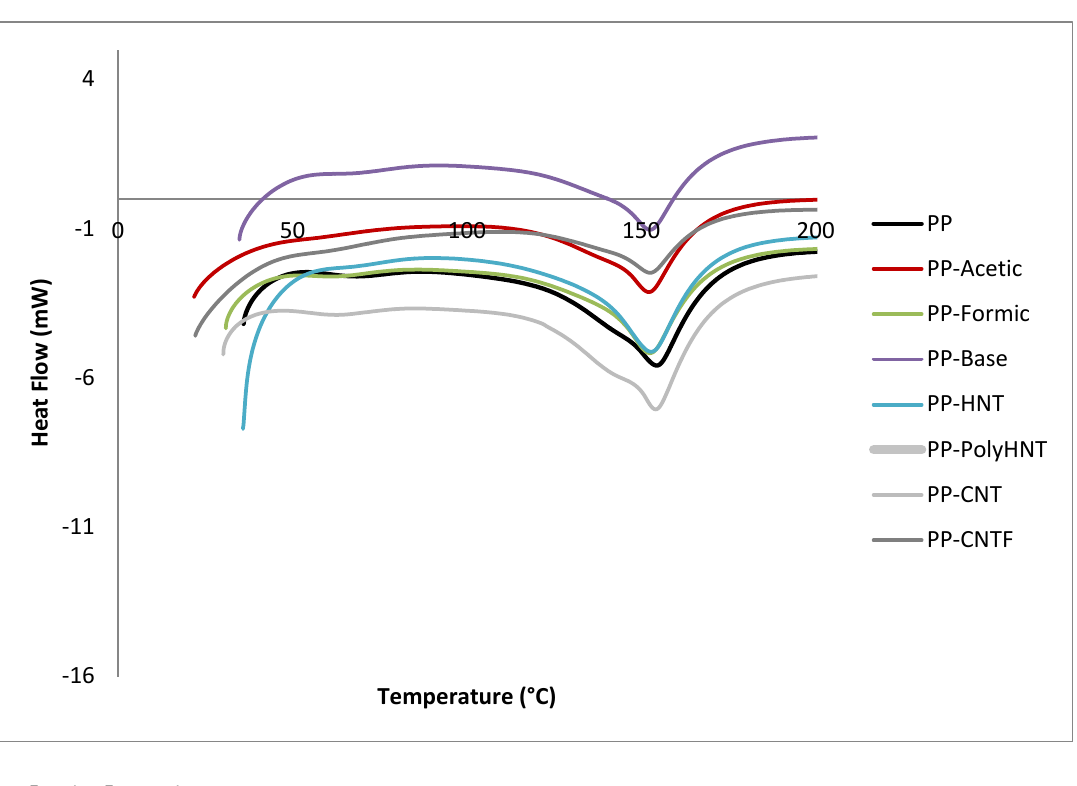
Figure 4. DSC curves extracted from DTA analysis for all